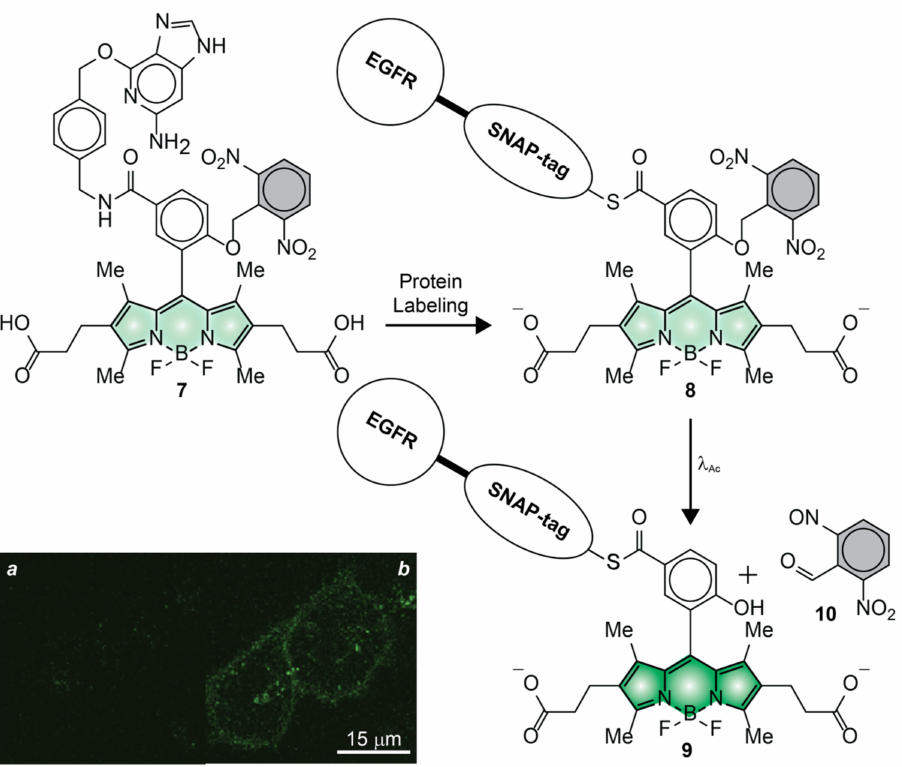
Figure 8. CLSM images of live HeLa cells, expressing EGFR–SNAP-tag labeled with 7 , recorded before ( a ) and after ( b ) photoactivation [adapted with permission from Ref.